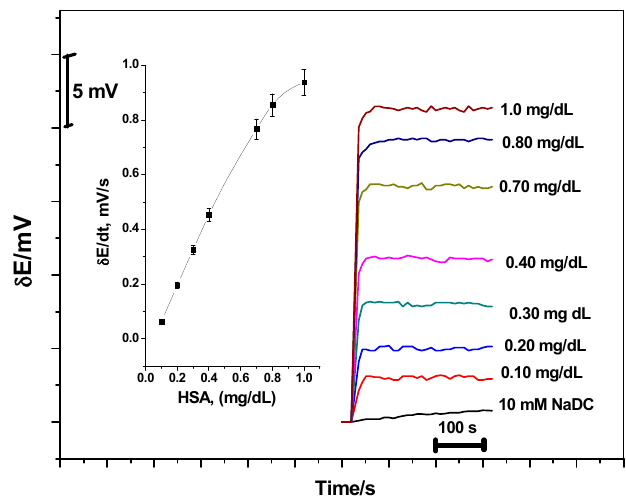
Figure 9. The dynamic potentiometric responses of screen-printed platform towards human serum albumin (HSA) and NaDC at pH = 9.2. The inset shows the measuring calibration plot for HSA. Table 3. Application of the proposed sensor to the determination of albumin in the human blood serum. Gender